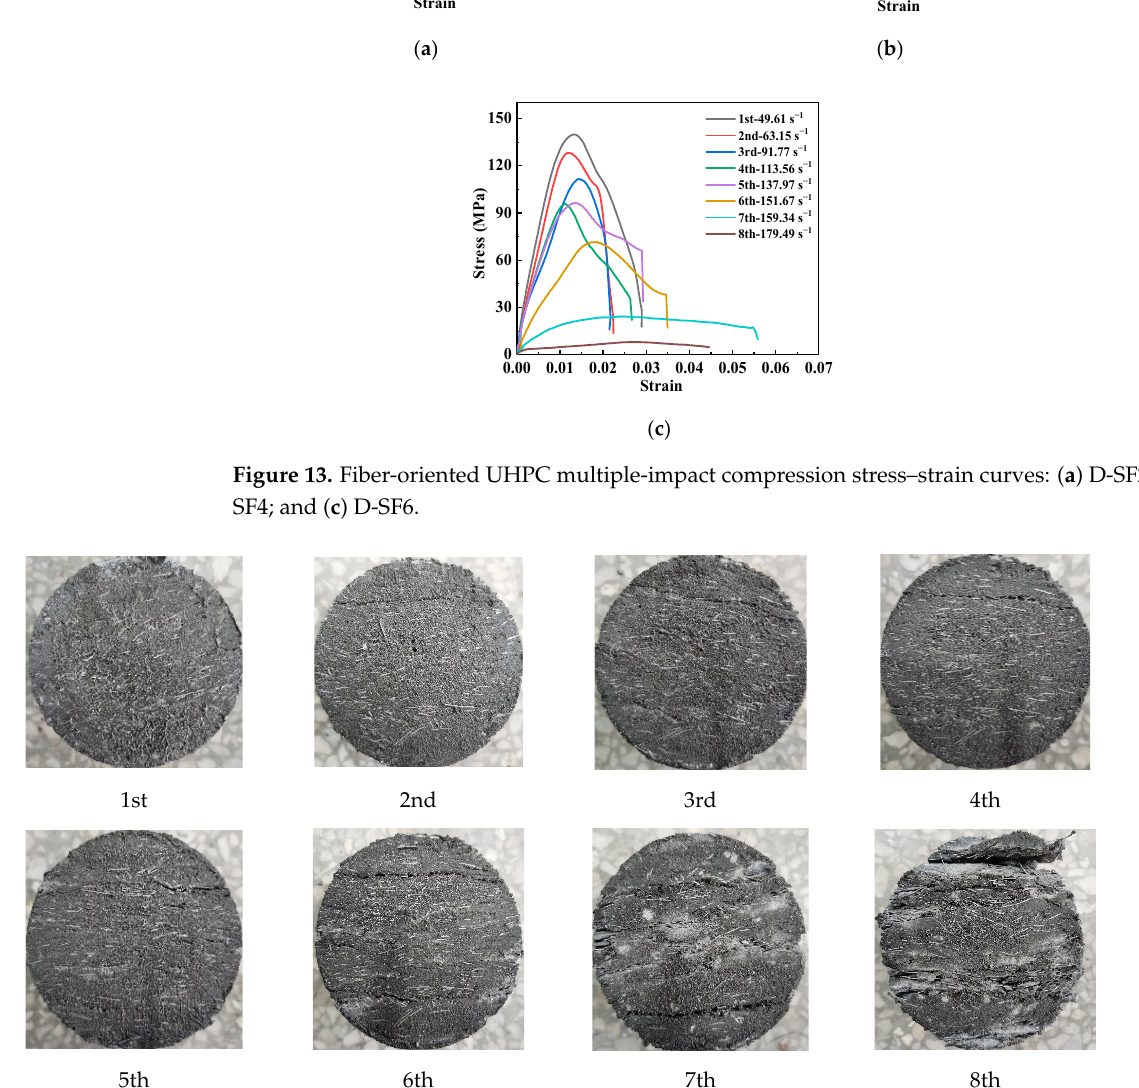
Figure 14. Failure mode of fiber-oriented multiple-impact compression specimens.